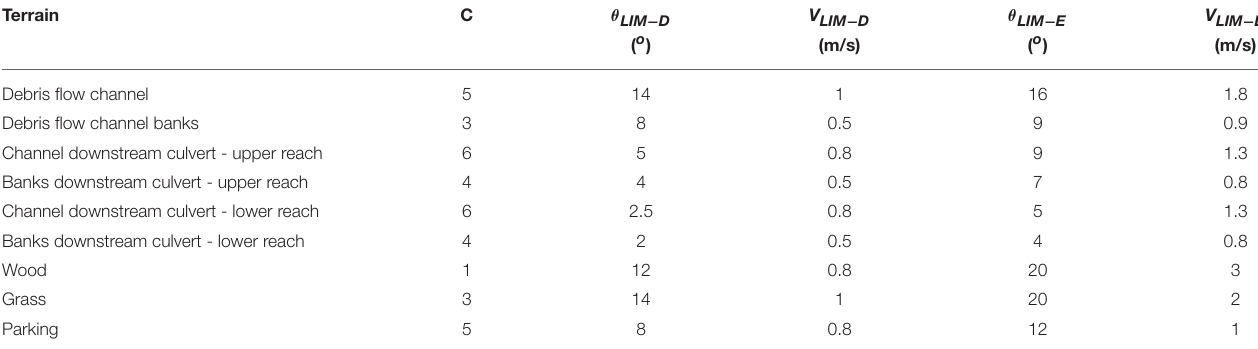
TABLE 3 | Values of the parameters used in the routing simulations for the different terrains.